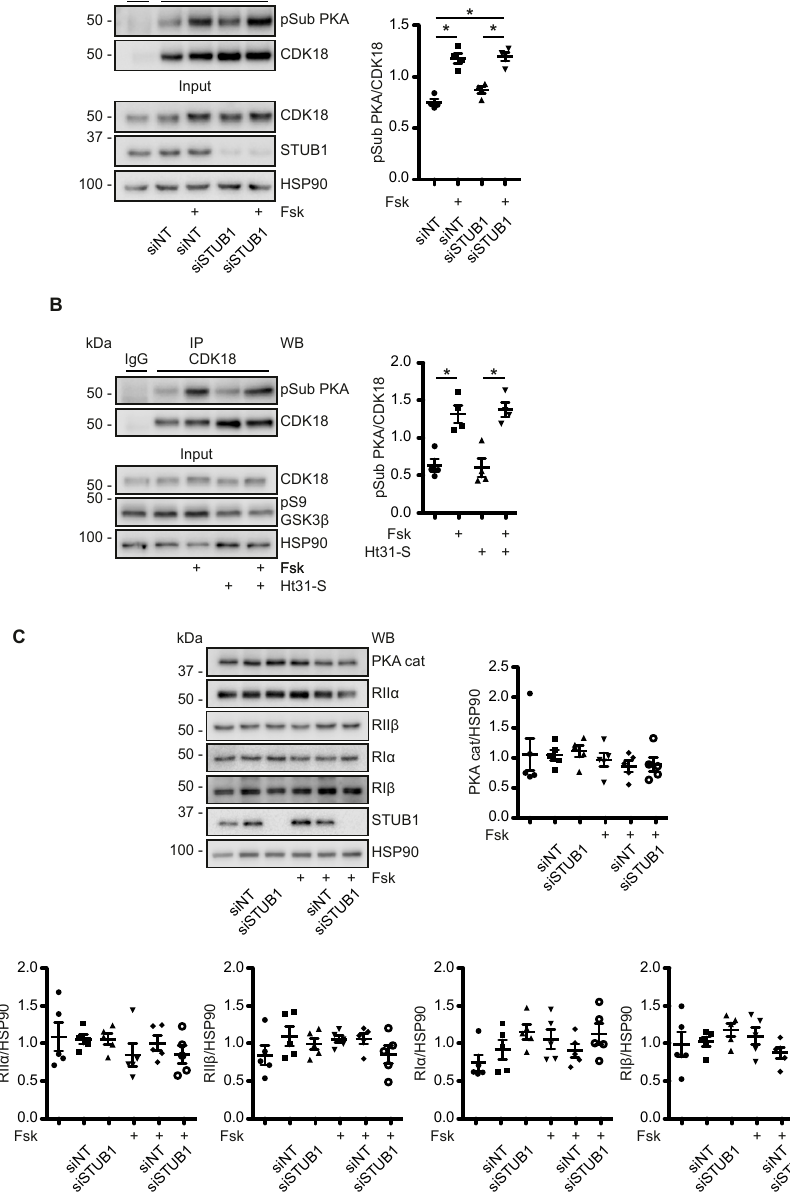
Figure 6. A cytosolic, STUB1-independent pool of PKA phosphorylates CDK18. ( A ) MCD4 cells were transfected with non-targeting (siNT) or STUB1 siRNA and left untreated or were treated with forskolin (Fsk) in the absence or ( B ) presence of a stearate-coupled, membrane-permeant version of the